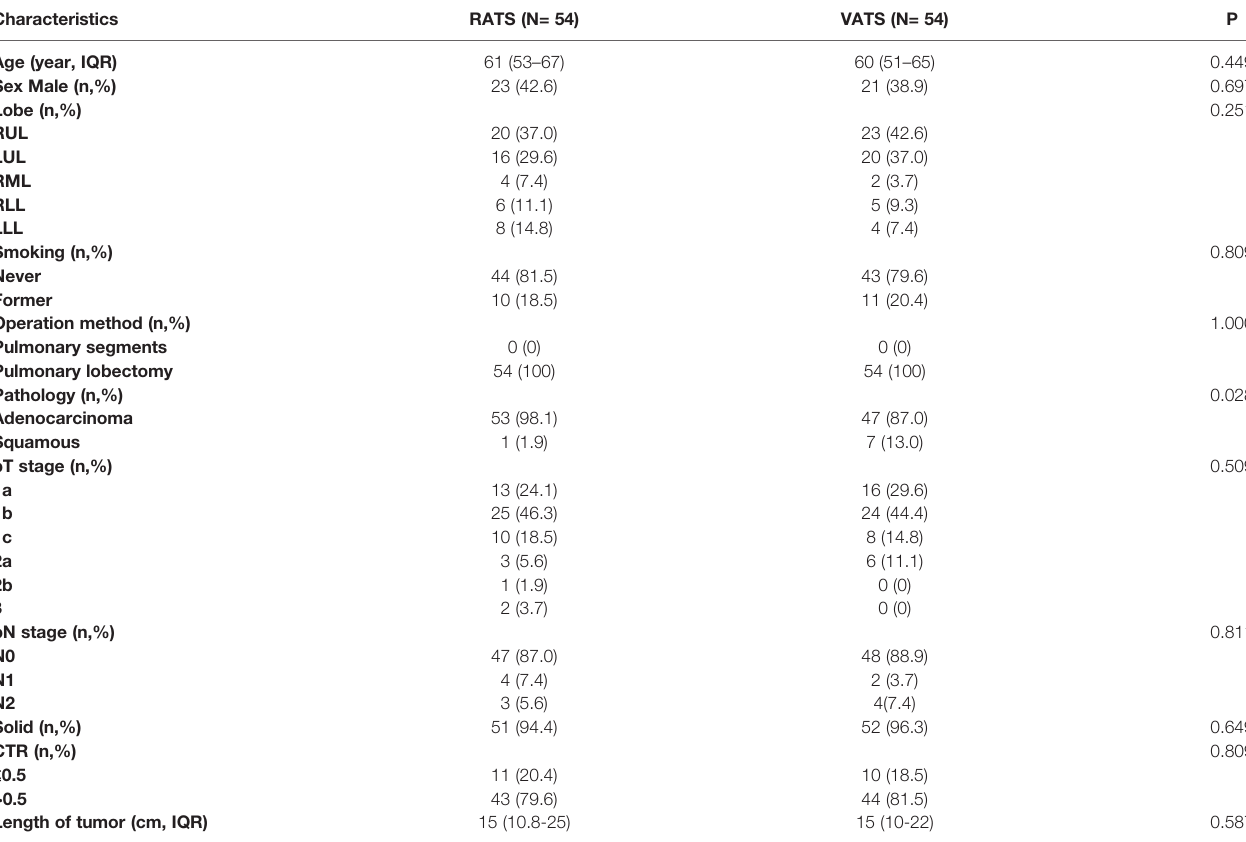
TABLE 2 | Patient and disease characteristics of the propensity score – matched groups (N = 108). Characteristics